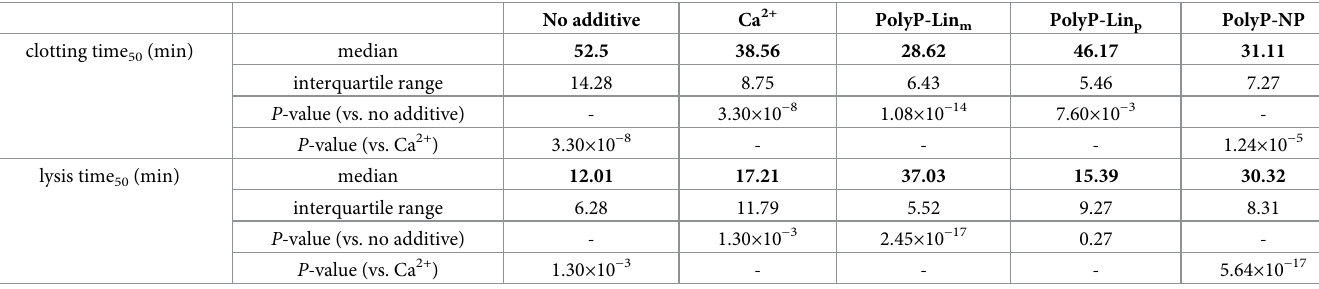
Table 2. Effects of different types of polyphosphates on fibrin formation and clot